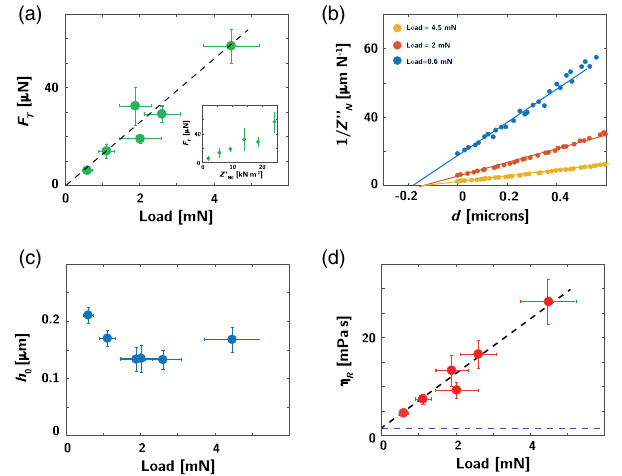
FIG. 6. Variations of the frictional and rheological properties of the interface with the prescribed load. (a) Friction evolution with the integrated load, highlighting a linear relation typical of a solidlike friction. (b) Retract curves for different regu- lating loads, showing a change in the slope rather than in the confinement distance with the regulating load. (c),(d) h 0 and η R as a function of the regulating load. The change in friction increase is shown to relate to the change in the local dissipative viscosity. The horizontal blue dashed line in (d) corresponds to the viscosity of supercooled water at − 6 °C. The data correspond to measurements performed with a hydrophobic